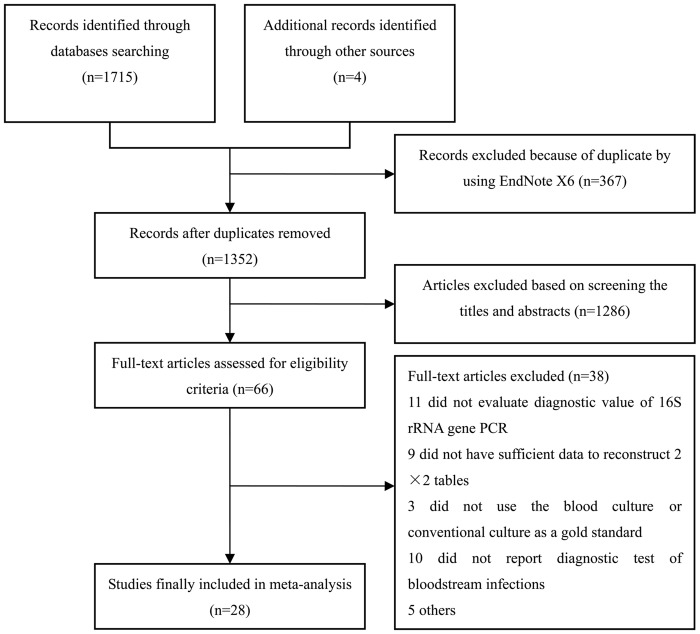
Flow chart of selection process for eligible studies.